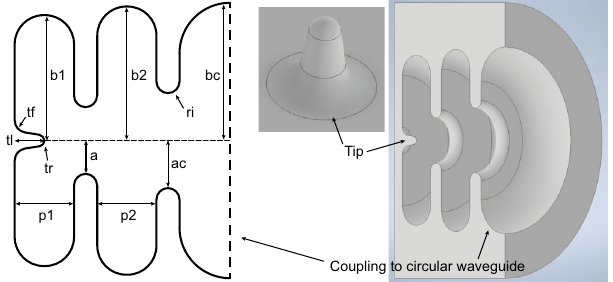
FIG. 1. Schematic and model of the copper tip gun. The structure is cylindrically symmetric around the horizontal dashed line shown. The structure consists of two cells, a copper tip (the cathode) located in the center of the first cell, and a coupling section. Input power is coupled in on-axis through a circular